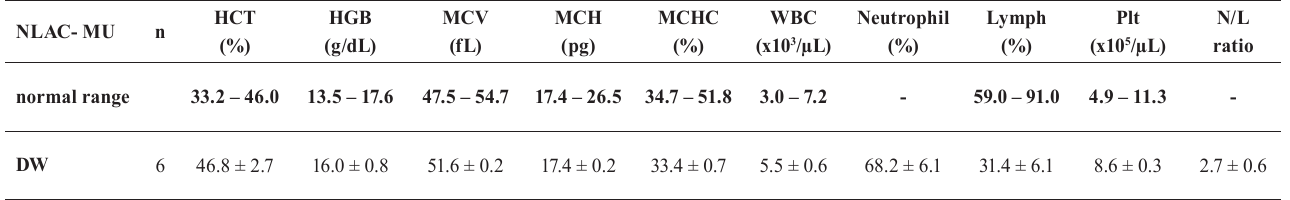
TABLE I - E ffects of CMP (1 g/kg) or distilled water (DW) consumption by middle-aged male rats on complete blood count NLAC-